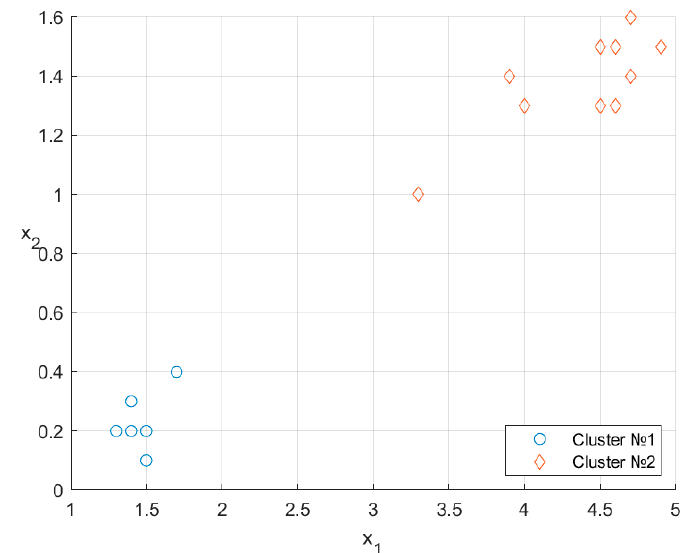
Figure 1. Data points on the two-dimensional